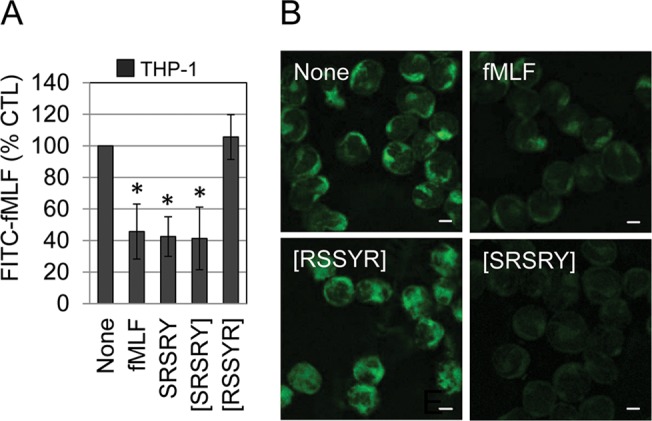
The peptide [SRSRY] binds to FPR1 on THP-1 cell surface.A. THP-1 cells (1.5 x106 cells/sample) were pre-incubated with diluents (None), 100 nM fMLF, 100 nM SRSRY or 100 nM [SRSRY] peptides for 60 minutes at 4°C, then exposed to 10 nM N-formyl-Nle-Leu-Phe-Nle-Tyr-Lys-fluorescein (FITC-fMLF) for additional 60 minutes at 4°C. Fluorimetric measurement of cell-associated fluorescence was assed using 485 nm excitation and 535 nm emission filters. Data are expressed as a percentage of the fluorescence associated to THP-1 cells exposed to FITC-fMLF alone (None = 100%) and represent a mean ± SD from triplicates. *Statistical significance (t-test) against None with p<0.001. B. THP-1 cells incubated with diluents (None), 100 nM fMLF, 100 nM SRSRY or 100 nM [SRSRY] peptides for 30 minutes at 37°C and exposed to 10 nM FITC-fMLF for additional 30 minutes at 37°C. Scale bar: 5 μm. Original magnifications: 630x.